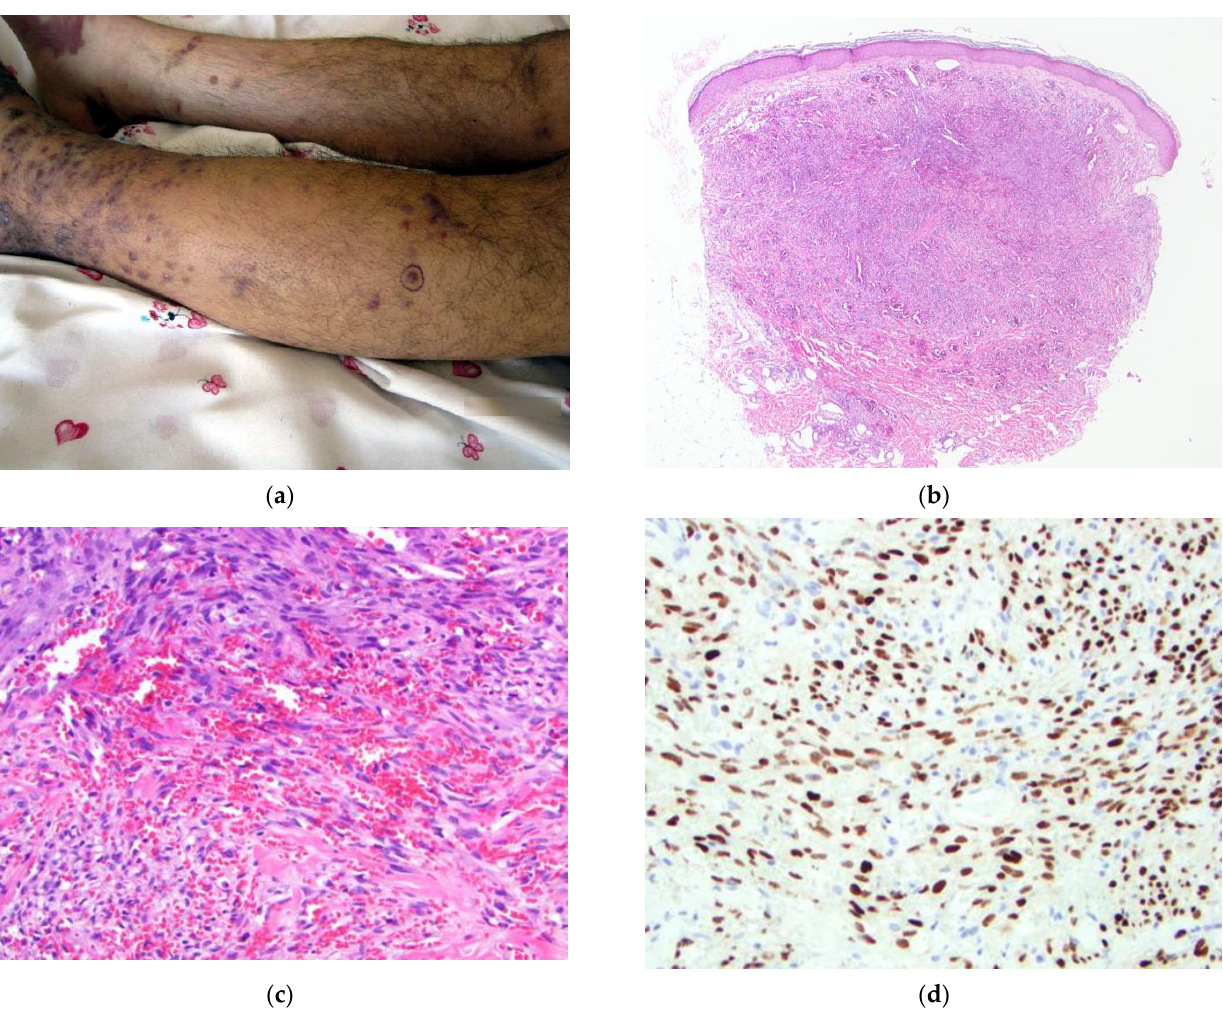
Figure 4. ( a – d ) Patient #4. Image ( a ) Multiple violaceous patches, nodules, and papules of the bilateral lower extremities with more significant involvement of the left leg. Biopsy site shown. Image ( b ) H&E 40×. Dermal-based nodularity. Image ( c ) H&E 200×. Spindled cell proliferation forming slit-like spaces. RBC extravasation is present. Image ( d ) IHC HHV-8 200×. Strong and diffuse nuclear staining of spindled cells within the dermis.